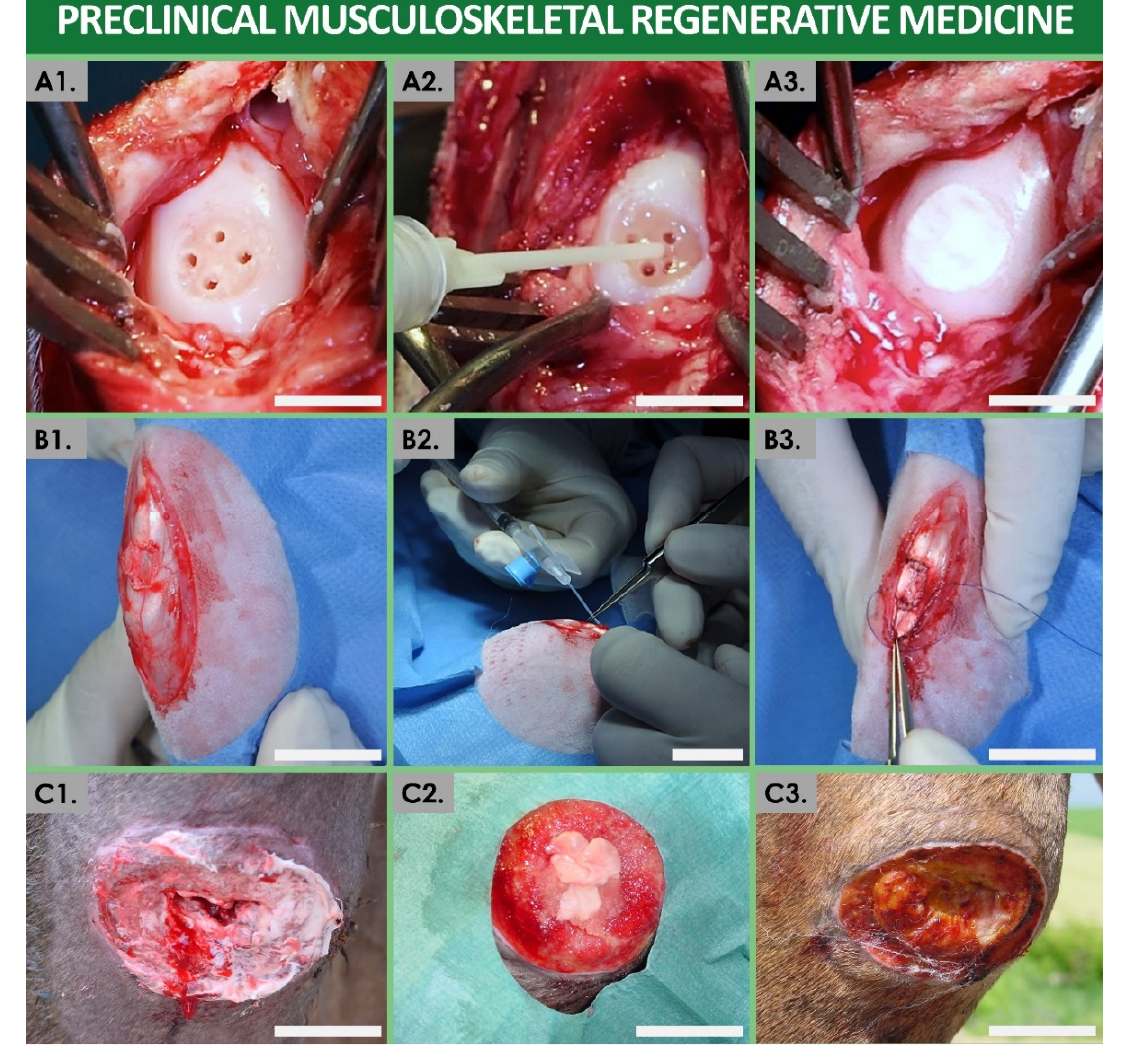
Figure 3. Illustrative overview of obtained preclinical results using homologous progenitor cell-based preparations in Swiss musculoskeletal regenerative medicine. ( A ) Illustration of cartilage lesion treatment using human progenitor chondrocyte-based constructs in a caprine model of full-thickness articular cartilage defect. Microfracture drill holes are created in the subchondral bone plate ( A1 ), fibrin glue is locally administered in the lesion ( A2 ), and the bioengineered cell-laden therapeutic construct is securely implanted in the defect ( A3 ). Scale bars = 8 mm. ( B ) Illustration of tendon tissue lesion treatment using human progenitor tenocyte-based hydrogels in a lagomorph model of patellar tendon defect. The mid-thickness tendon tissue defect is evidenced ( B1 ), the therapeutic cell-laden hydrogel product is injected locally into the partially sutured defect ( B2 ), and the tissue defect is closed and sutured ( B3 ). Scale bars = 2 cm. ( C ) Illustration of a case study of volumetric soft tissue loss in the joint of a female pony, treated with complex equine progenitor cell-based progenitor biological bandages (ePBBs). The initial wound ( C1 ) was appropriately cleaned and treated with PBBs ( C2 ), leading to rapid healing evolution of the wound after three days ( C3 ). Scale bars = 2 cm. ePBB, equine progenitor biological bandage. Modified and adapted with permission from Laurent et al., 2020, 2021a, and 2021b